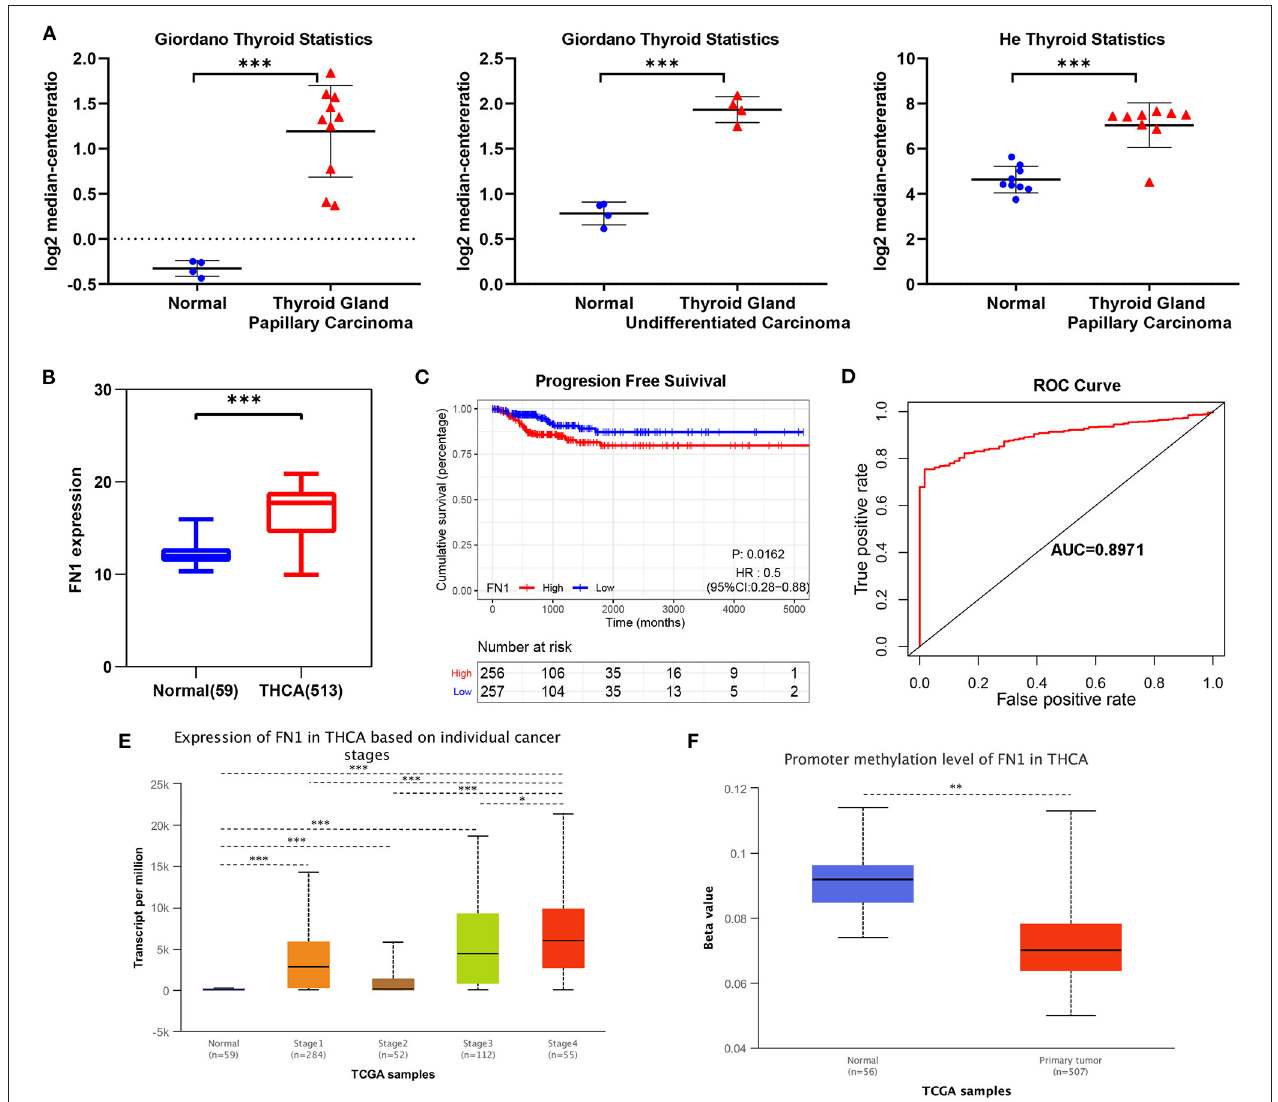
FIGURE 3 | Transcriptional expressions of FN1 significantly correlated with poor survival outcomes in THCA patients from TCGA cohort. (A) The expression of FN1 in different subtypes of THCA. (B) The expressions of FN1 in THCA patients from TCGA-THCA cohort, (C) The correlation between the expression of FN1 and PFS, (D) ROC curve with an AUC of 0.8971. Transcriptional expression of FN1 was significantly correlated with individual cancer stages (E) and promoter methylation (F) . * p < 0.05, ** p < 0.01, *** p <